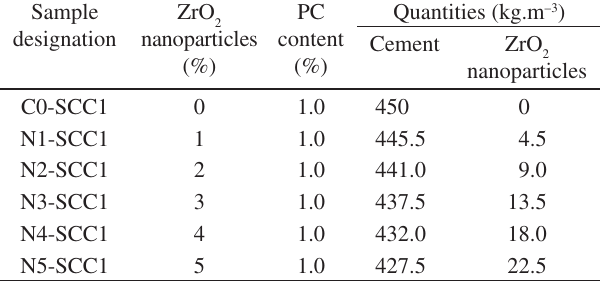
particles blended self compacting 2